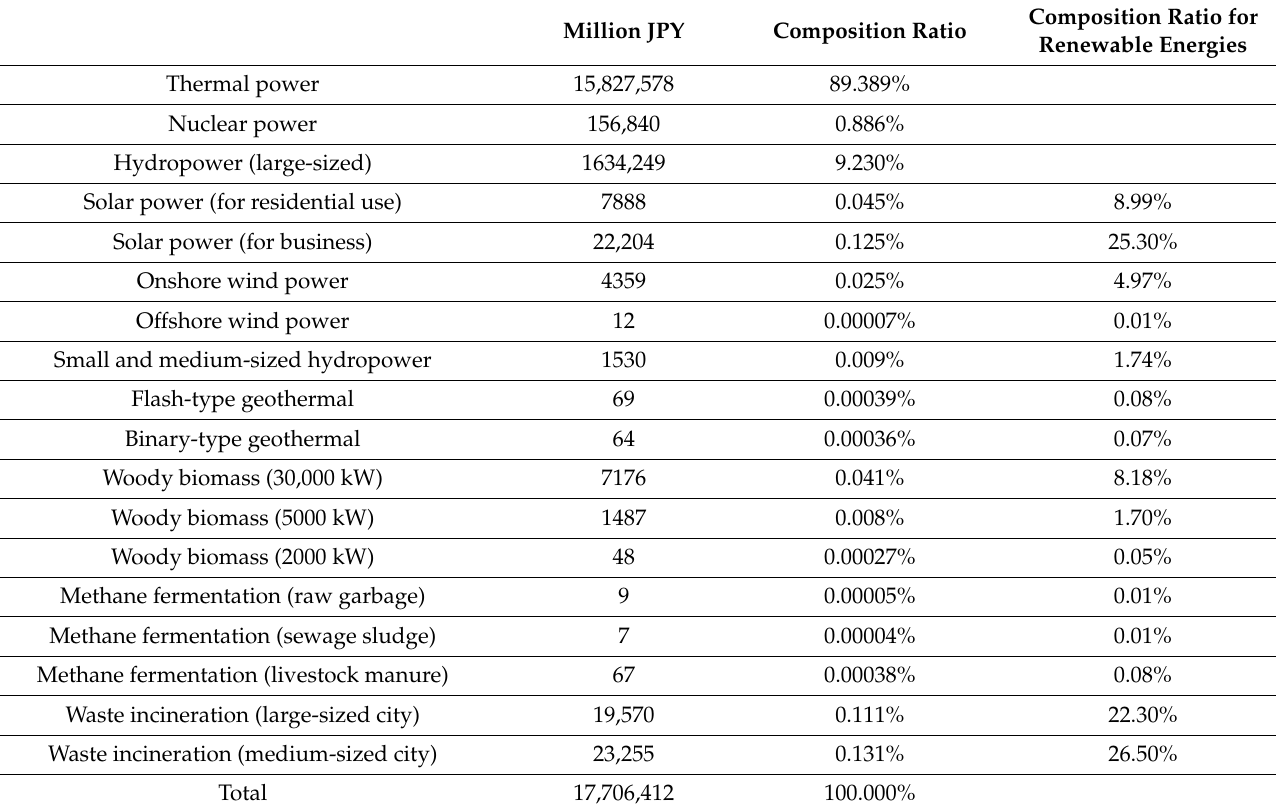
Table A2. Domestic demand of the commercial power-generation sector in the 2015 IONGES.